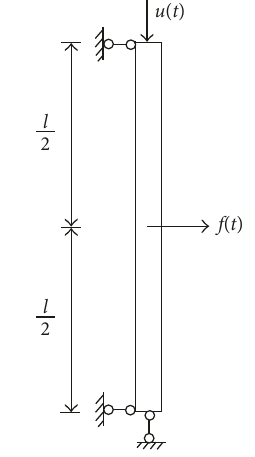
Figure 3: Diagram of the forced